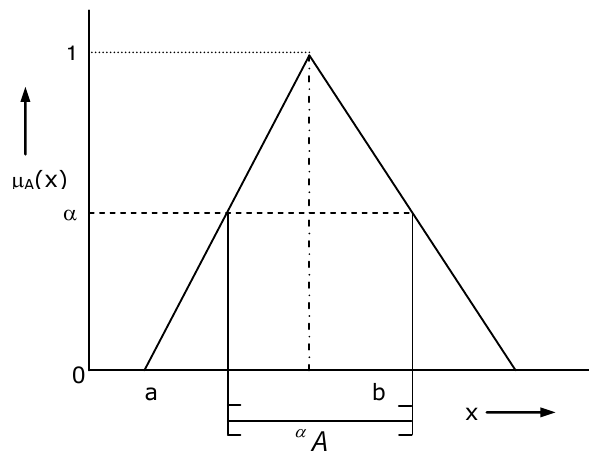
Figure 1. Triangular fuzzy membership function and  -cut